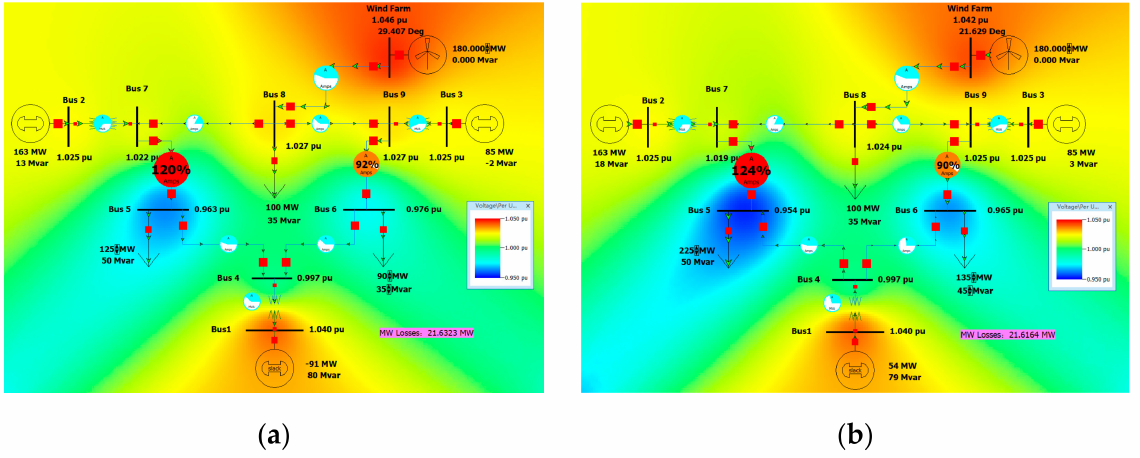
Figure 12. Simulation results when tower B is connected to bus 8 (150 km) after adding induc- tance. ( a ) The results under the minimum load condition and ( b ) the results under the maximum load